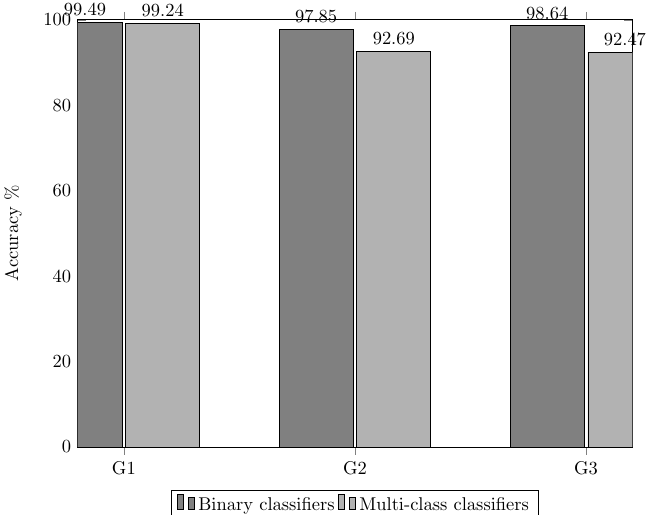
Figure 11. Experiment 4. Results of the classification in 3 wide groups using the model 2 on the groups 1, 2 and